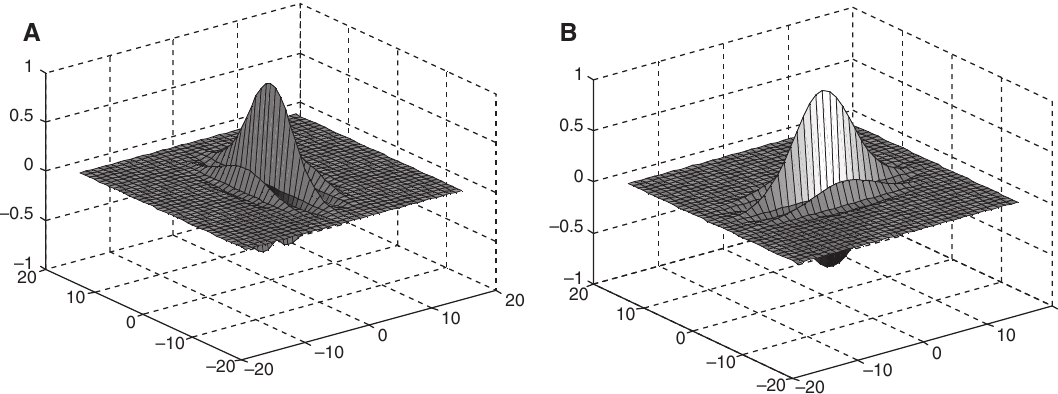
Figure 4: 3D Plot of Gabor Filters with Two Different Value of